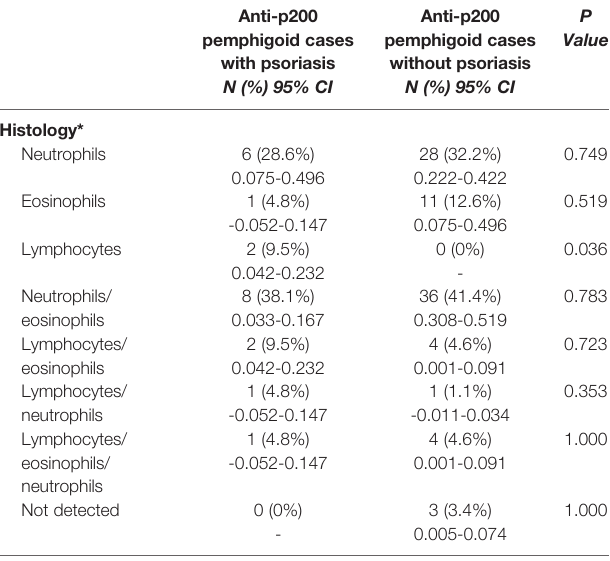
TABLE 3 | Histology feature in reported